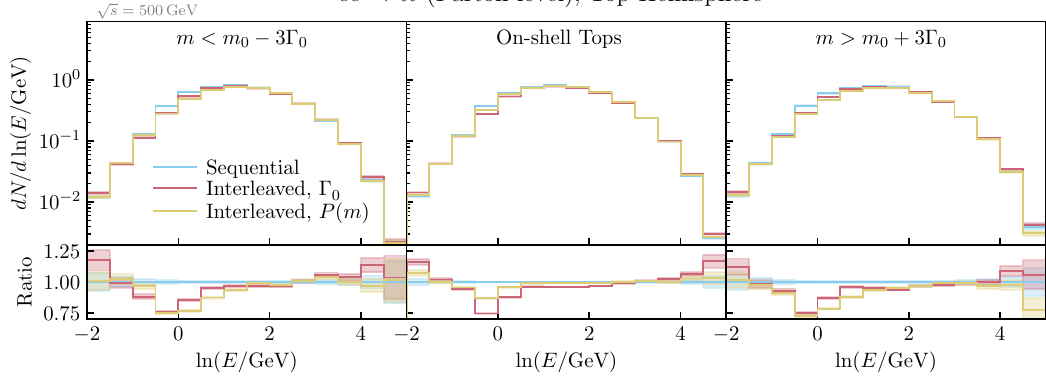
Figure 6: Logarithmic energy spectrum of partons emitted in the top hemisphere, at the shower cutoff scale, for (left) low-mass tops with m < m | < Γ / 2, and (right) high-mass tops with m > m tops with | m − m 0 0 the spectra are all normalised to the cross sections of their respective